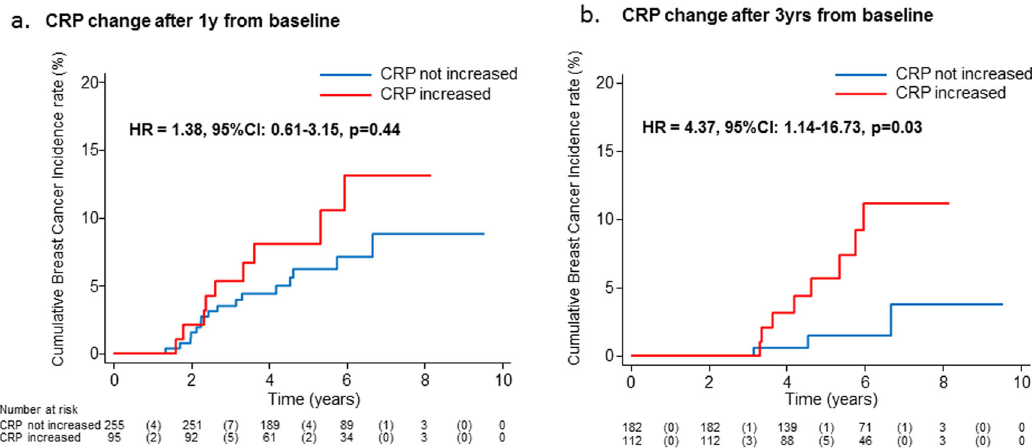
Fig. 2 Cumulative breast cancer recurrence according to C-reactive protein increase. Results are shown irrespective of treatment allocation at 1 year ( a ) and 3 years ( b ). Hazard ratios were adjusted for age, BMI, and treatment